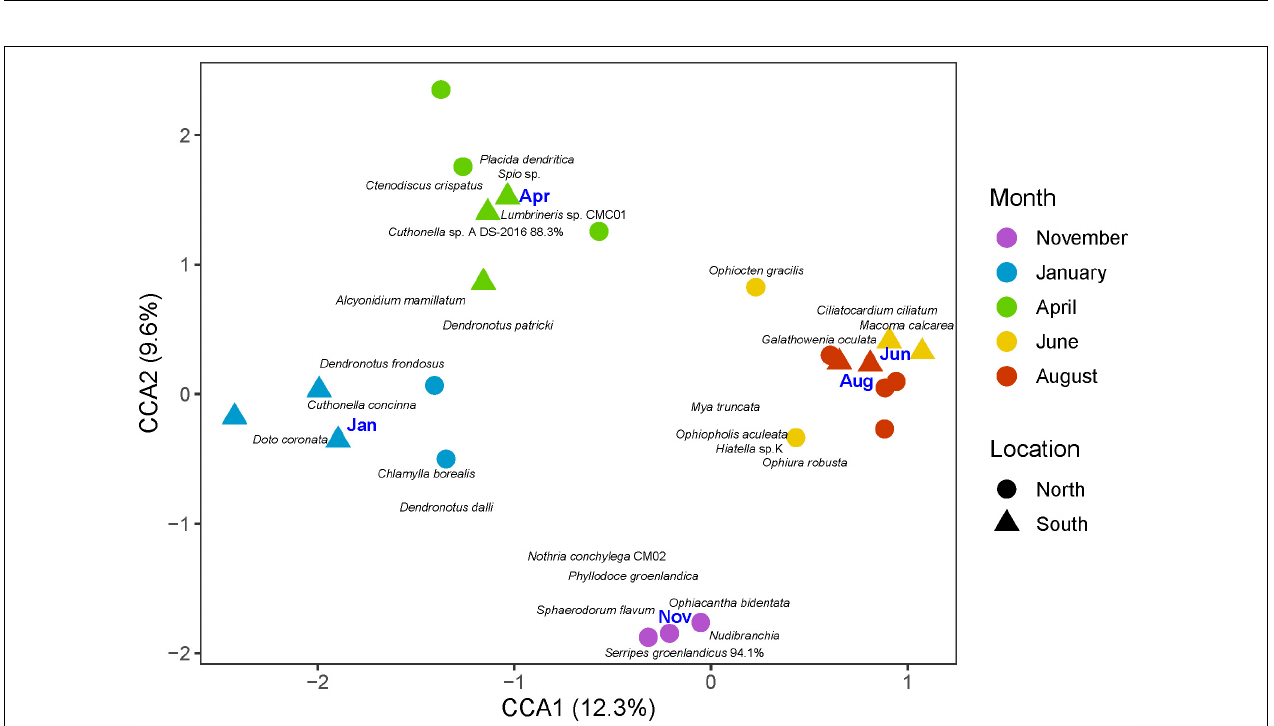
FIGURE 8 | Similarity of meroplankton communities across months (colors), north and south of the Polar Front (symbols) shown in a canonical correspondence analysis (CCA) plot based on fourth-root transformed meroplankton abundance data. Each point represents a single sample per month, location and depth layer. The blue month labels are centroids for the corresponding months. The first axis explains 12.3% of the variance while the second explains 9.6%.